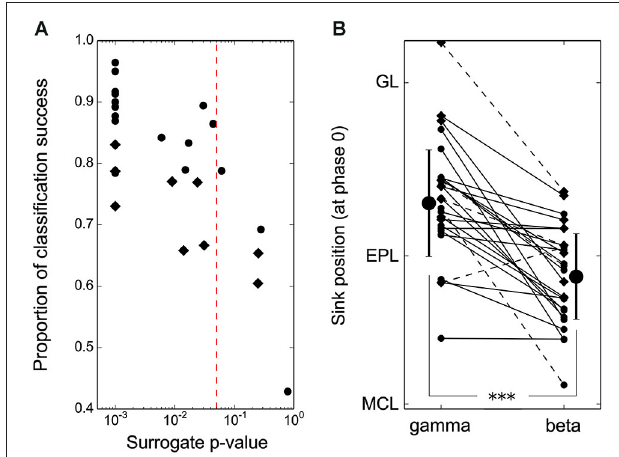
FIGURE 3 | Spatial shift of beta and gamma EPL activation is significant at the single recording site level. (A) Results of the leave-one-out classification test performed individually at each recording site (50- µ m spaced electrodes: round markers, 100- µ m spaced electrodes: diamond markers). The p -values reported on the x-axis were obtained by comparing single recording site actual data with 1000 randomizations of gamma/beta labels of every CSD oscillation map from the same recording site. The vertical red line indicates the 0.05 significance threshold. Note that 100- µ m spaced electrodes most often have significant beta/gamma classifications but with lower classification rate success due to poorer spatial resolution. (B) Position of the EPL sink at phase 0 for each individual CSD map (average across recordings from a single recording site location) during the beta vs. gamma oscillations. Markers as in (A) , dashed lines correspond to cells with a non-significant beta/gamma classification test in (A) . The latter are not taken into account for group averages and standard deviations (large